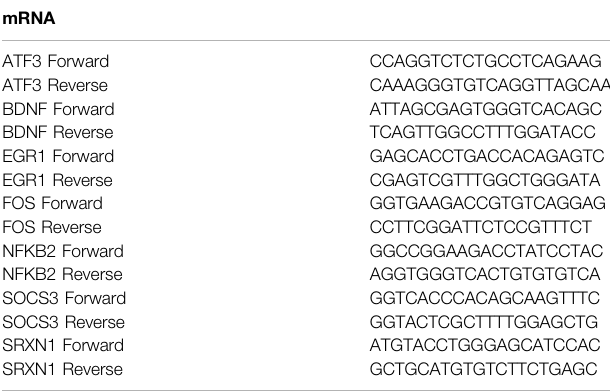
TABLE 1 | Sequences for each messenger RNA (mRNA) quantitative polymerase chain reaction